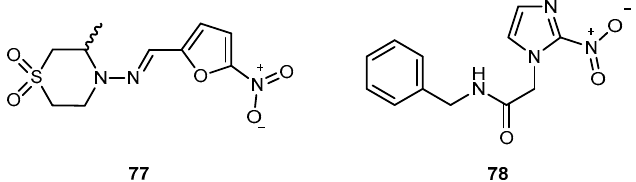
Figure 32. Chemical structures of trypanocidal drugs, nifurtimox ( 77 ) and benzindazole ( 78 ).